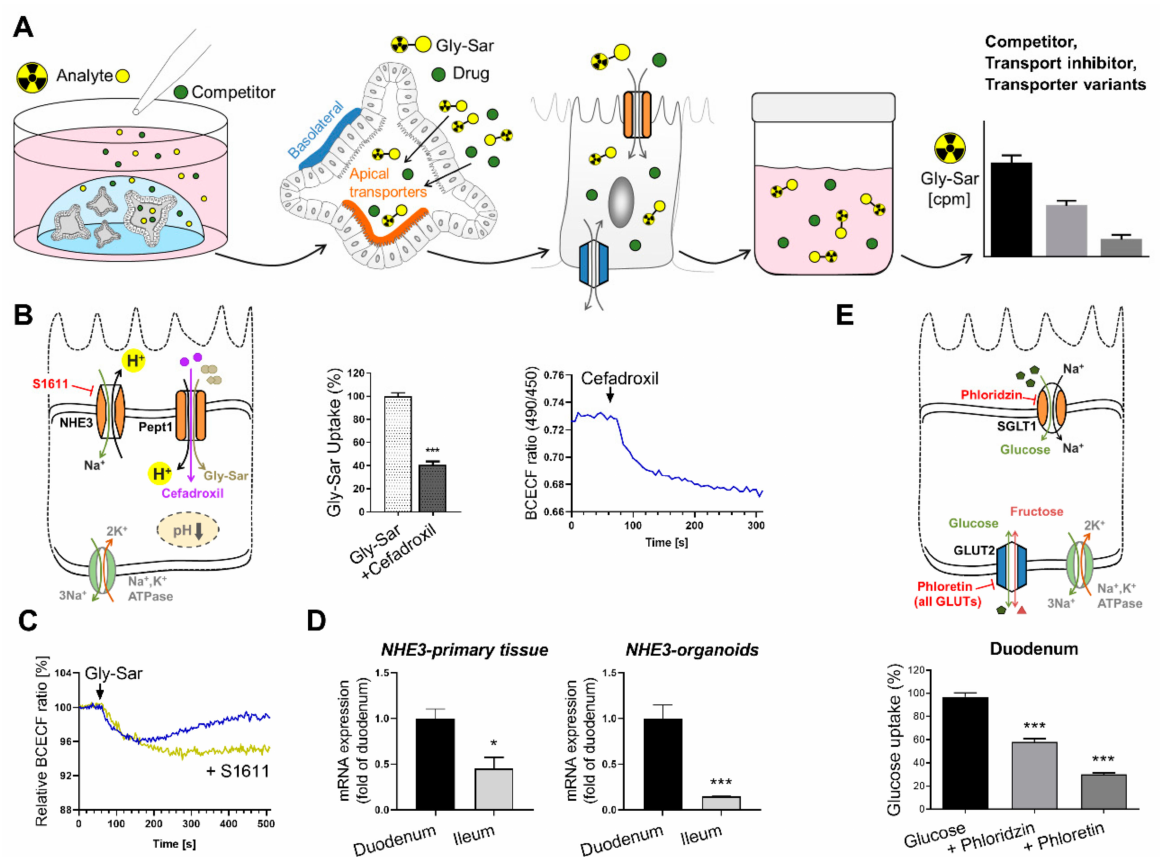
Figure 4. Workflow to study intestinal transport processes and downstream events in human intestinal organoids. ( A ) Schematic representation of the experimental procedures for measuring transport activity using radiolabeled substrates. ( B ) Left: schematic illustration of the transporters investigated, and inhibitor used. Middle: reduction of radiolabeled Gly-Sar (model substrate for PEPT1) uptake using the antibiotic cefadroxil as competitive inhibitor. Right: course of intracellular acidification induced by cefadroxil exposure. ( C ) Course of intracellular acidification induced by Gly-Sar exposure with the NHE3-inhibitor S1611, preventing reestablishment of cellular pH. ( D ) mRNA expression of NHE3 in primary tissue and organoids derived from different intestinal segments demonstrating region-specific gene expression in organoids. ( E ) Upper panel: Schematic illustration of the transporters investigated, and inhibitors used. Lower panel: uptake of radiolabeled glucose in organoids derived from duodenal tissue. Asterisks indicate significant differences * p < 0.05, *** p < 0.001; Figures and graphs adapted from [9], Front. Bioeng. Biotechnol.